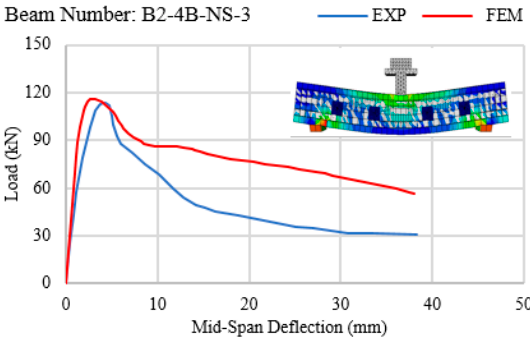
Figure 15. Load vs. mid-span deflection for B2-NS.